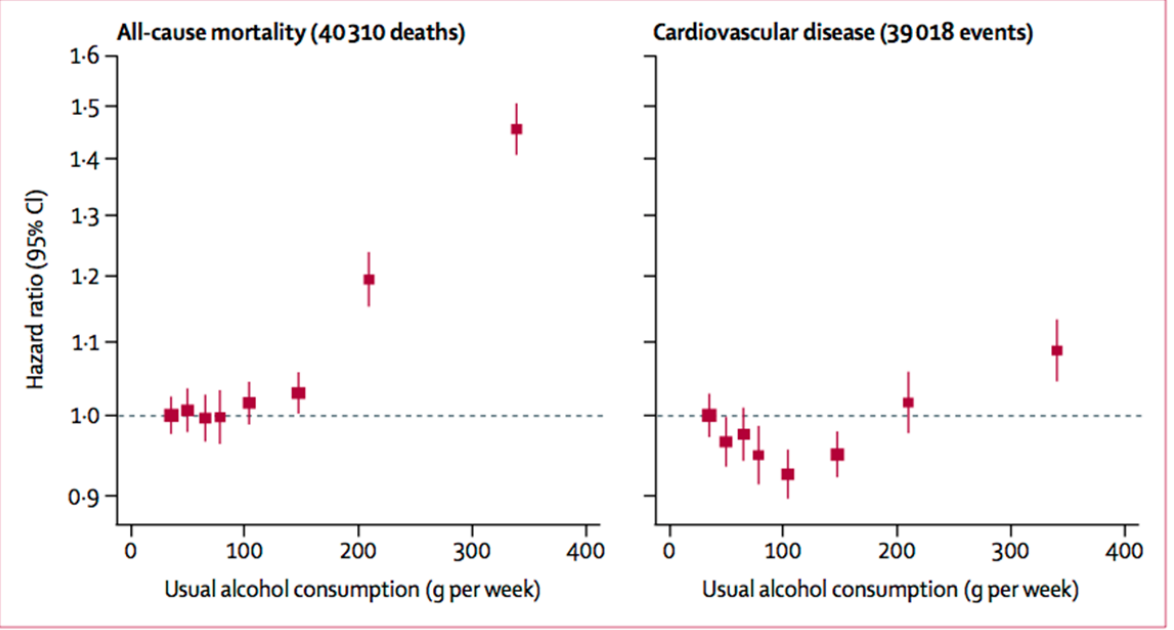
Figure 1. Associations of usual alcohol consumption with all-cause mortality and the aggregate of cardiovascular disease in current drinkers (Reproduced from The Lancet 2018; 391: